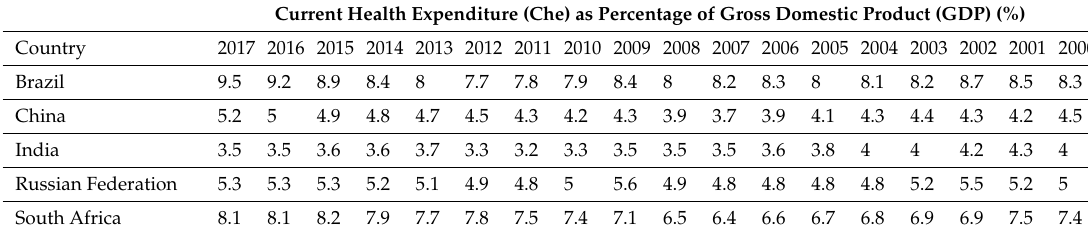
Table A1. Health Expenditure (CHE) as per percentage of gross domestic product (GDP) (%) table of